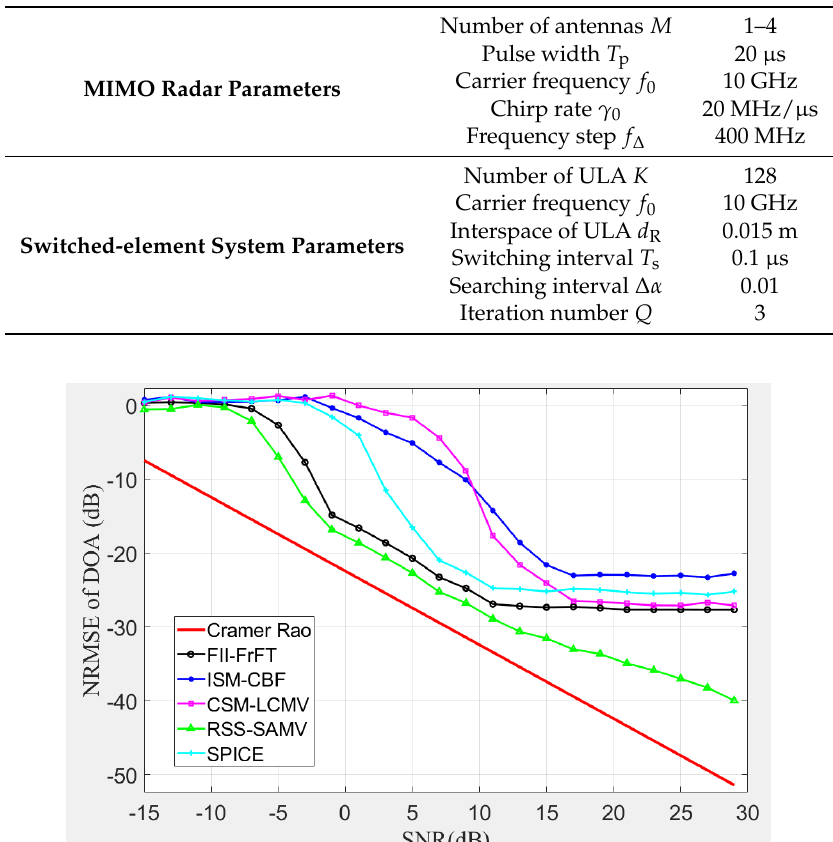
Table 1. Parameter Settings.